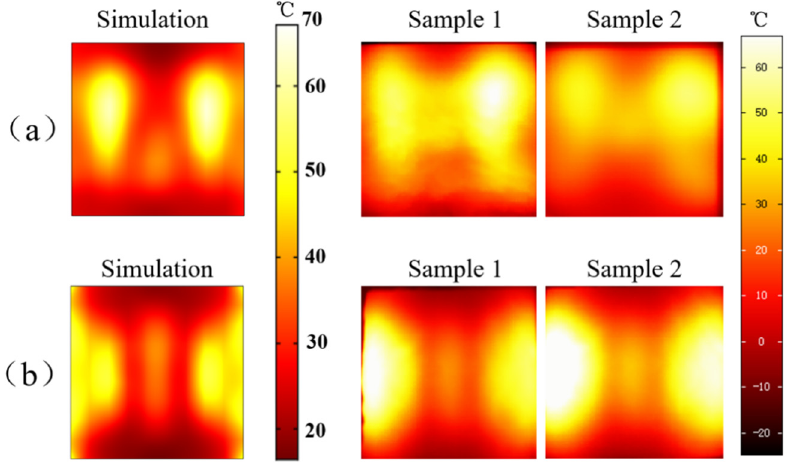
Figure 10. Temperature distribution of simulations and experiments on the upper surface of potatoes: ( a ) cavity height: 200 mm; ( b ) cavity height: 230